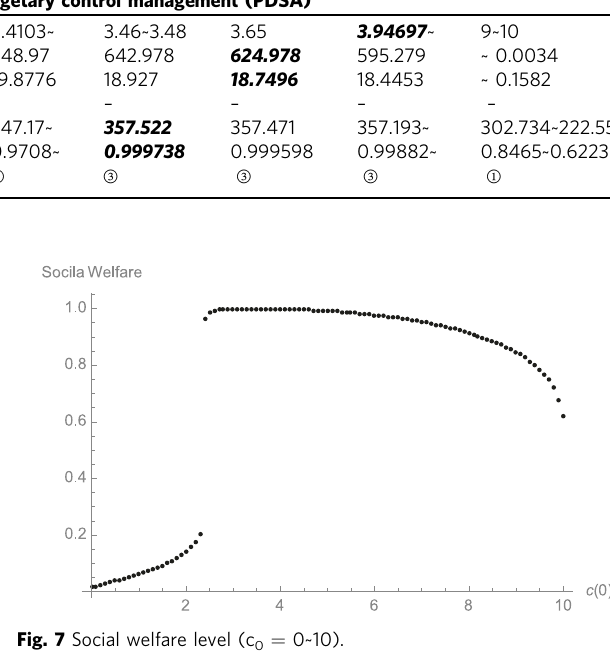
Fig. 6 Budget-controlled growth paths and the optimal growth path.